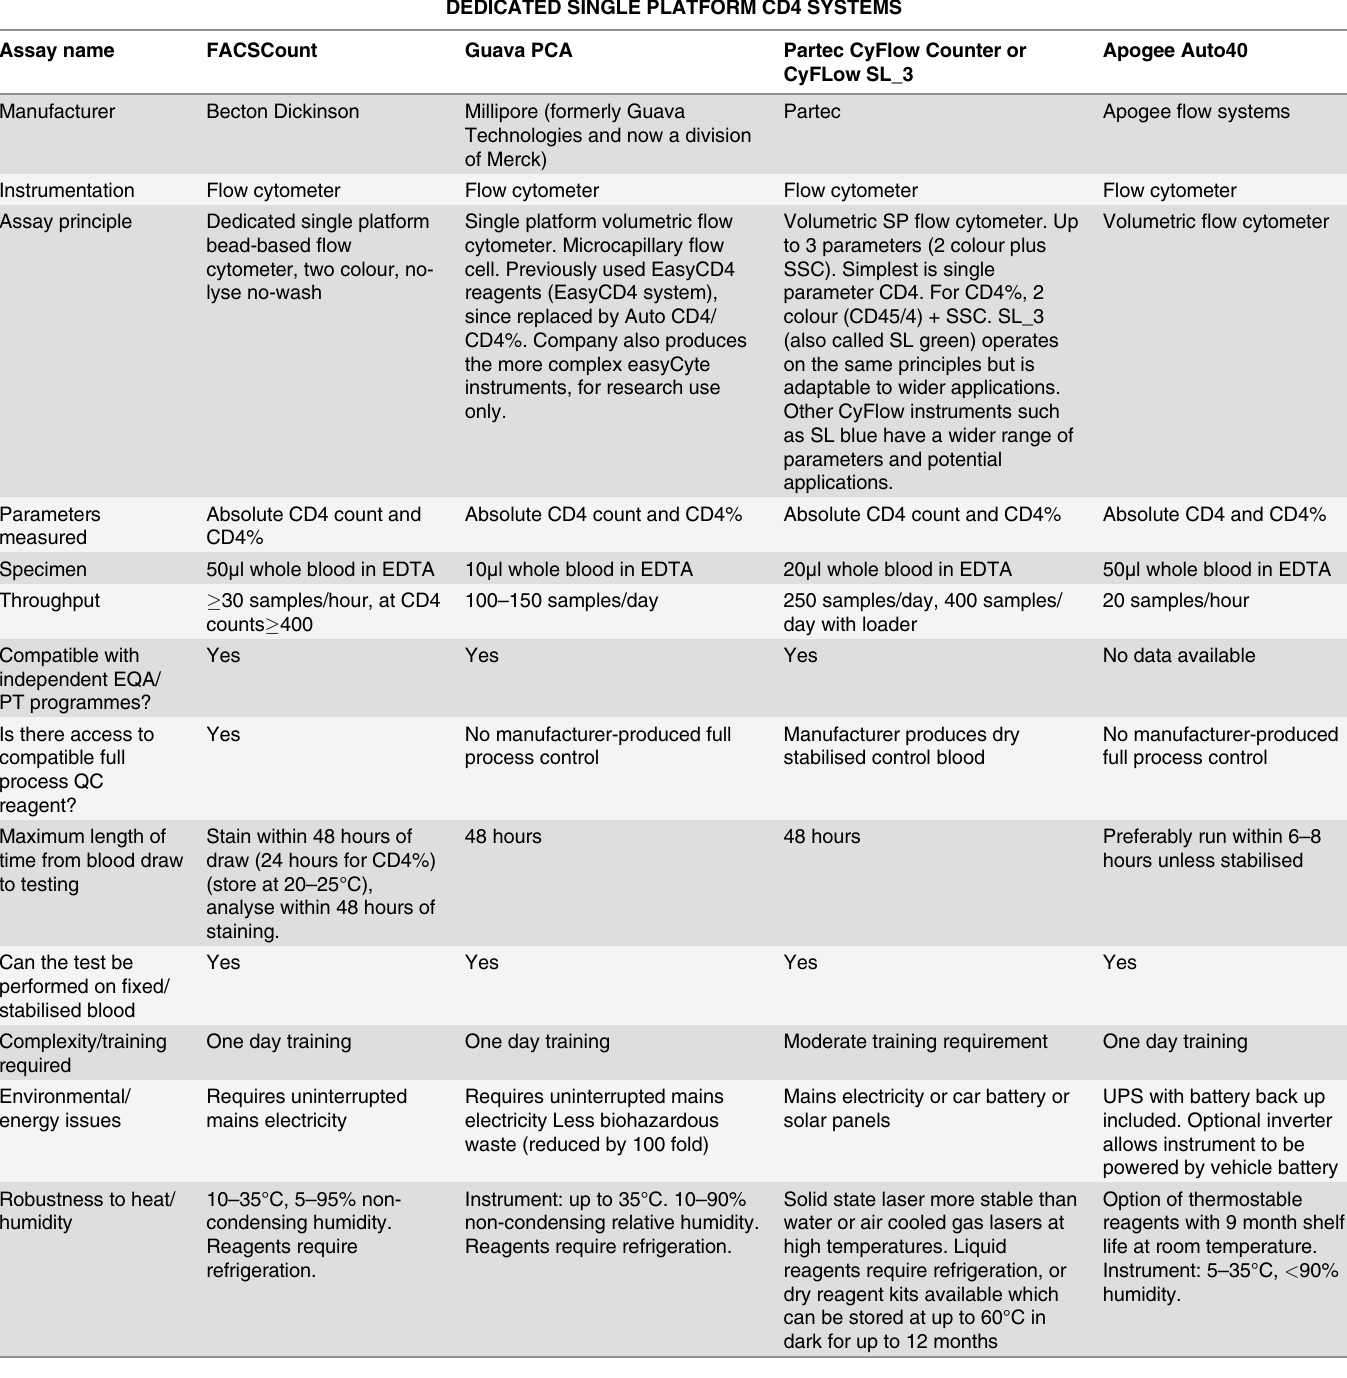
Table 2. Operating characteristics of dedicated single platform CD4+ T-cell enumeration